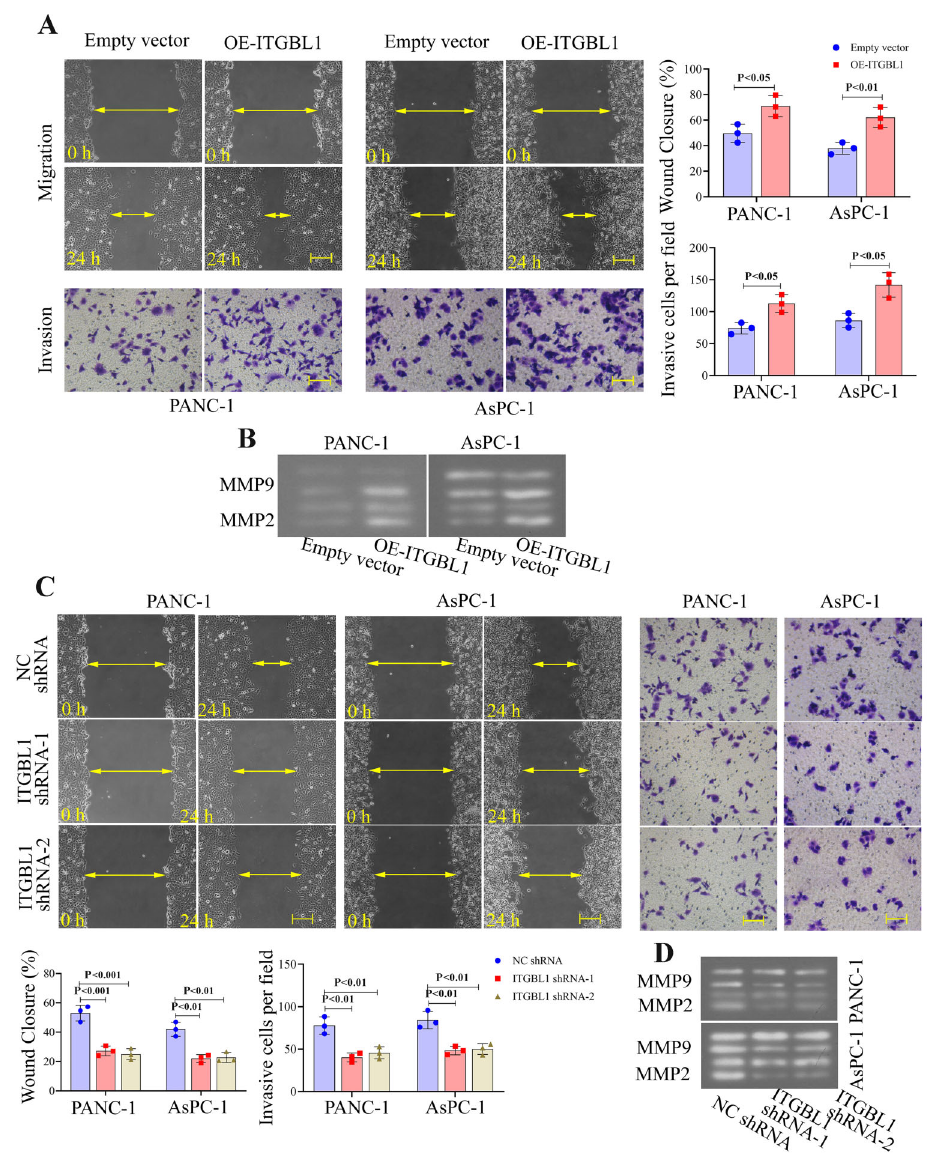
Figure 4. ITGBL1 promoted the migration and invasion of pancreatic cancer cells A and C , Cell migration and invasion in ITGBL1- overexpressed (OE-ITGBL1) or silenced cells were evaluated by wound healing (scale bar=200 m m) and transwell invasion (scale bar=100 m m) assays, respectively. B and D , The activities of MMP2 and MMP9 in the supernatant of ITGBL1-overexpressed or silenced cells were measured by gelatin zymography assay. Data are reported as means ± SD for N=3